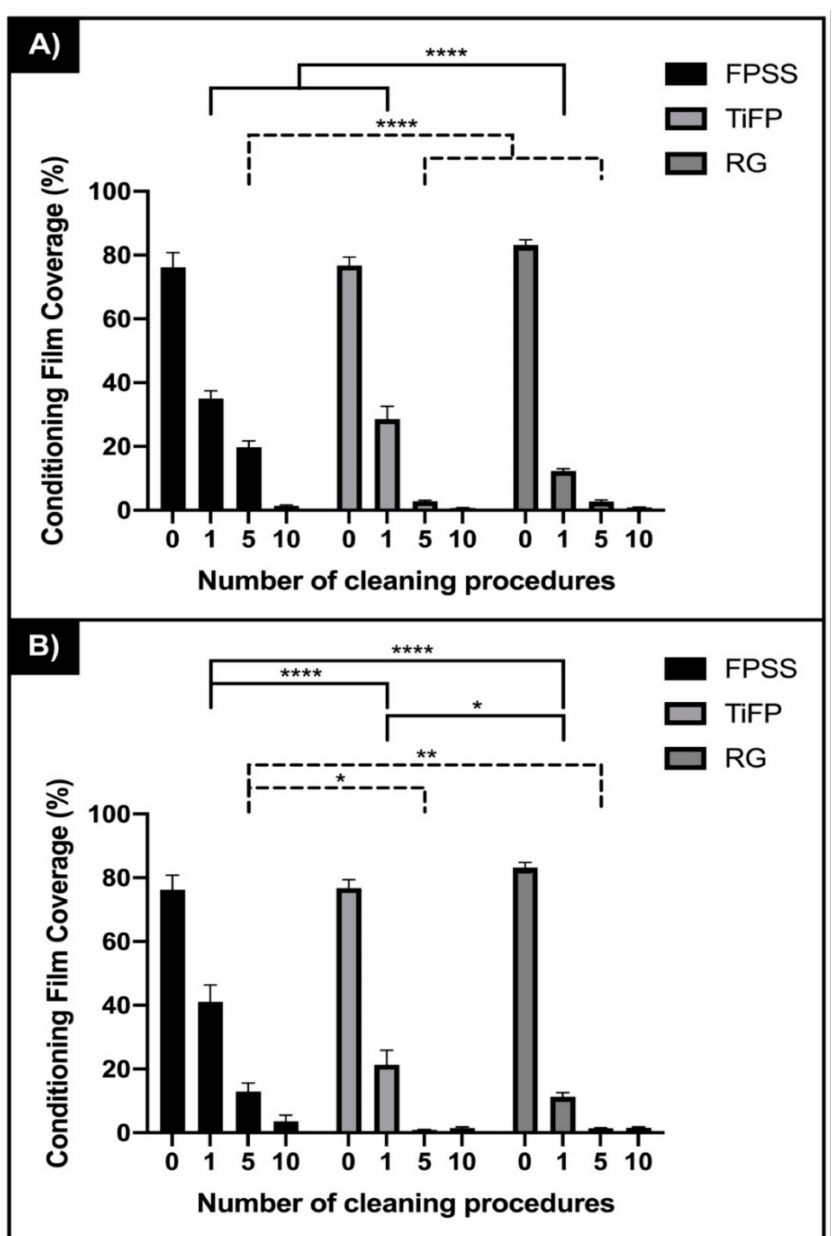
Figure 3. Percentage coverage of meat exudate retained on fine polished stainless steel (FPSS), titanium polished stainless steel (TiFP) and the regular linear featured titanium coated surface (RG) surface following 0, 1, 5 and 10 cleans ( A ) along the direction and ( B ) perpendicular to the surface features ( n = 45). Asterisks denote significance, * p ≤ 0.05, ** p ≤ 0.01 and **** p ≤ 0.0001. The amount of bacteria and meat exudate removed from the surfaces following cleaning along linear features compared to cleaning in a perpendicular direction to the linear features, demonstrated that there was no significant difference ( p > 0.05) in the removal of cells (with the exception five cleans on the FPTi). However, the meat exudate demonstrated a different trend whereby by ten cleans, the meat exudate was significantly more removed when the surfaces were cleaned in the direction along the surface features ( p < 0.05). This result may have occurred due to the size of the bacterial cells and organic components of the meat exudate with respect to the size of the surface features (Figure